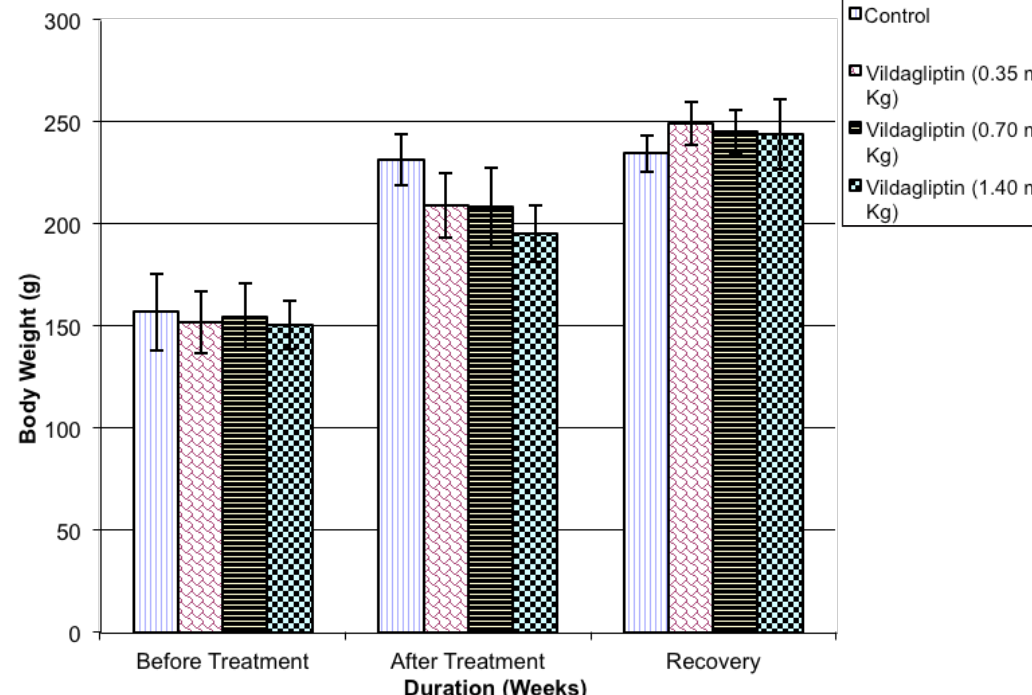
FIGURE 1 – Effects of vildagliptin on body weight of male Wistar rats. Graph showing the effects of vildagliptin on the percentage weight gain male Wistar rats. ** = significantly different from control (p < 0.01). *** = significantly different from control (p <